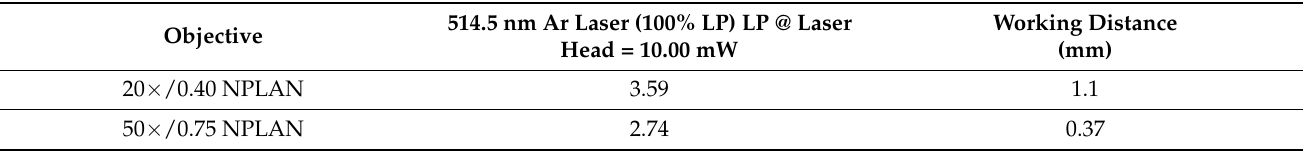
Table 2. Raman Spectroscopy laser power measured at the sample for 20 × and 50 × .